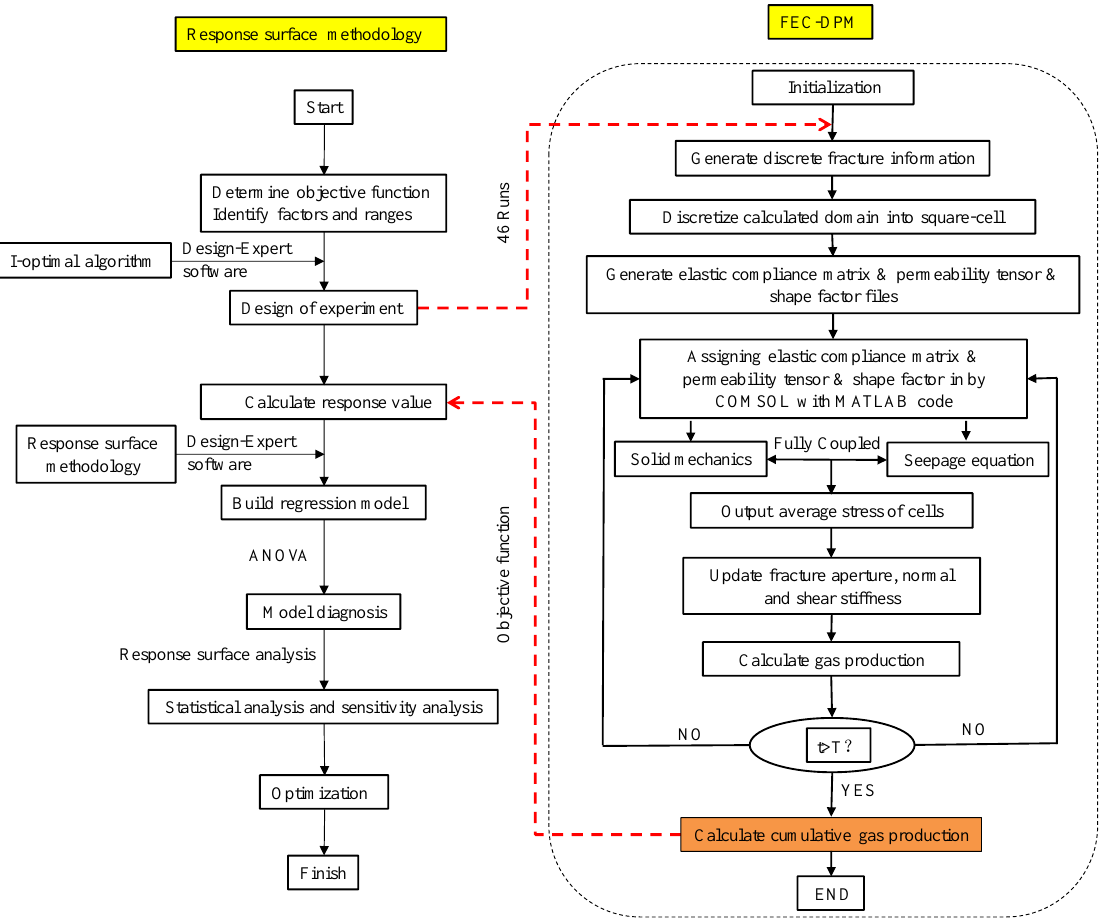
Figure 2. Flow chart of framework for RSM optimization of gas production.